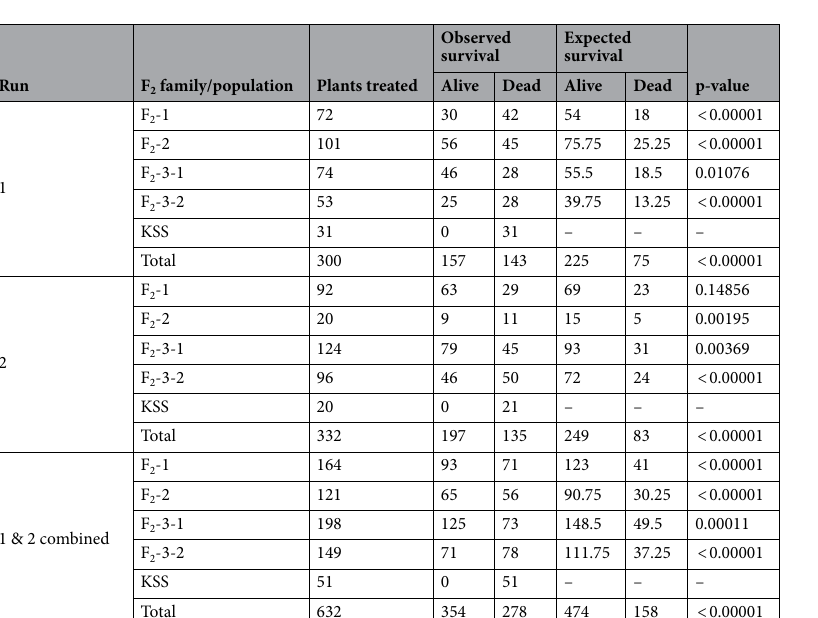
Table 4. Chi-square test for goodness of fit of the observed segregation of plants as resistance or susceptible (Eq. 4) to 2,4-D to the expected frequency for a single-locus model in pseudo-F 2 families of Palmer amaranth.